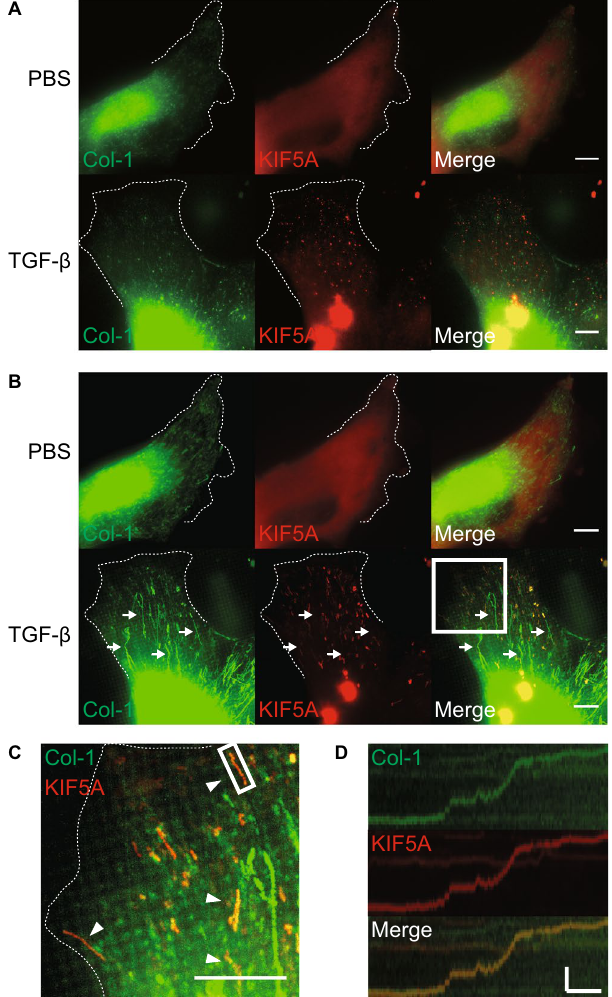
Figure 6. Live cell imaging of collagen transpotation in HPMC. ( A ) Snap-shot images of fluorescent protein labelled Col-1 and KIF5A with or without TGF- β stimulation in live HPMC. White dotted lines indicate